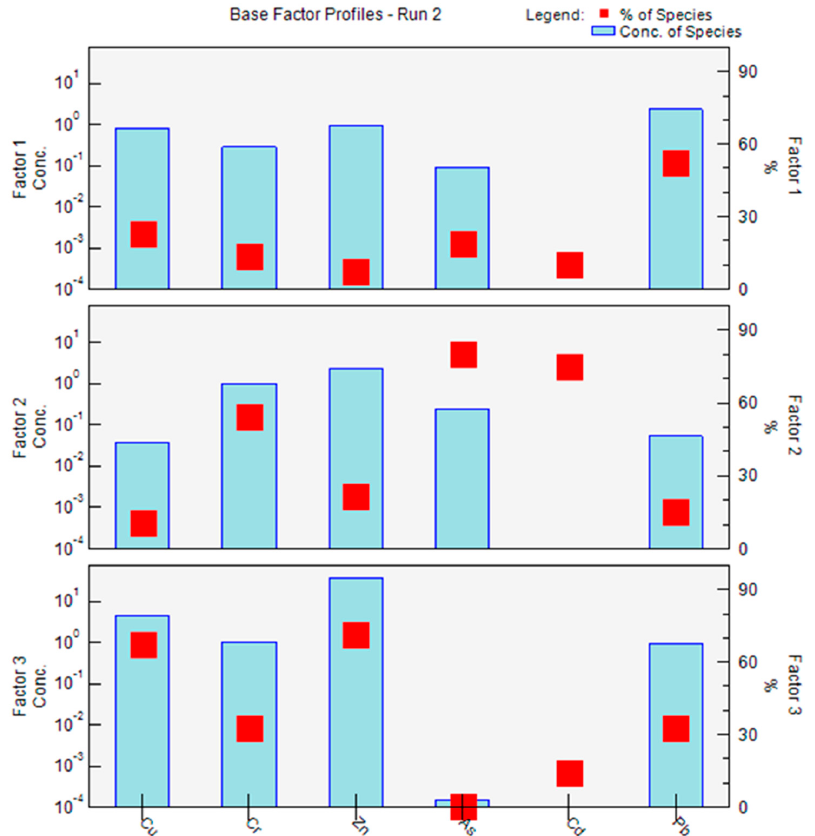
Figure 6. Source profiles and contributions of heavy metals in the studied Hulun Lake sediments obtained with the PMF model.